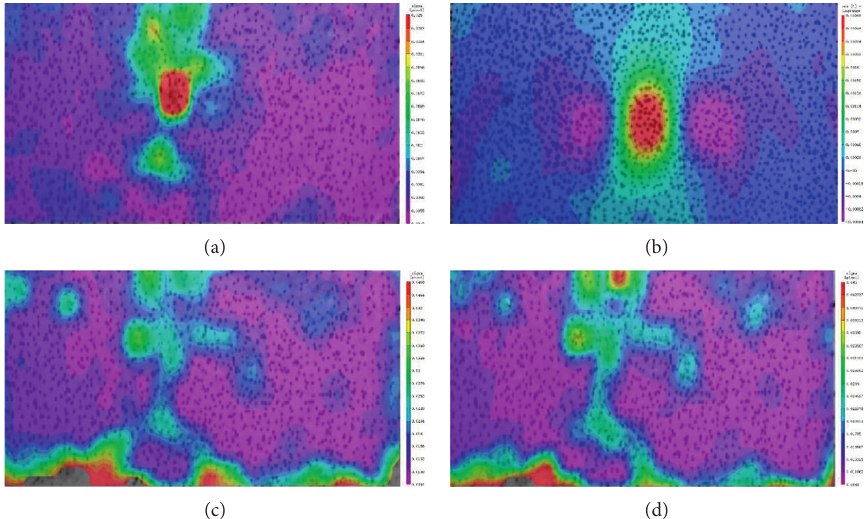
Figure 13: Strain cloud diagrams of failure process of reinforced concrete wall.